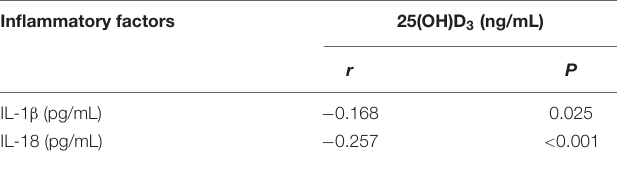
TABLE 4 | Spearman’s correlation of the association between 25(OH)D 3 and inflammatory factors in mild cognitive impairment (MCI). Inflammatory